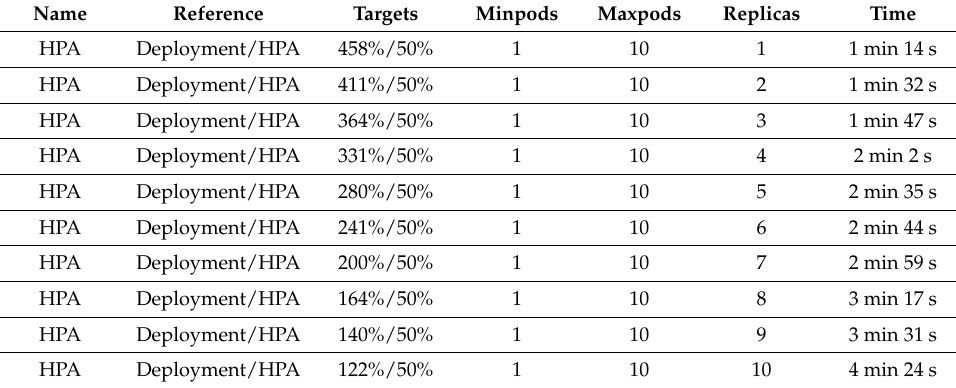
Table 2. HPA-based auto-scaling performance test results.